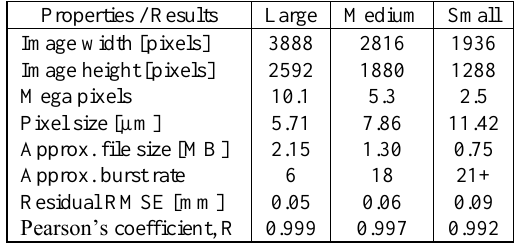
Table 1. Summary of the image properties and the sinusoidal fitting results for the large, medium, and